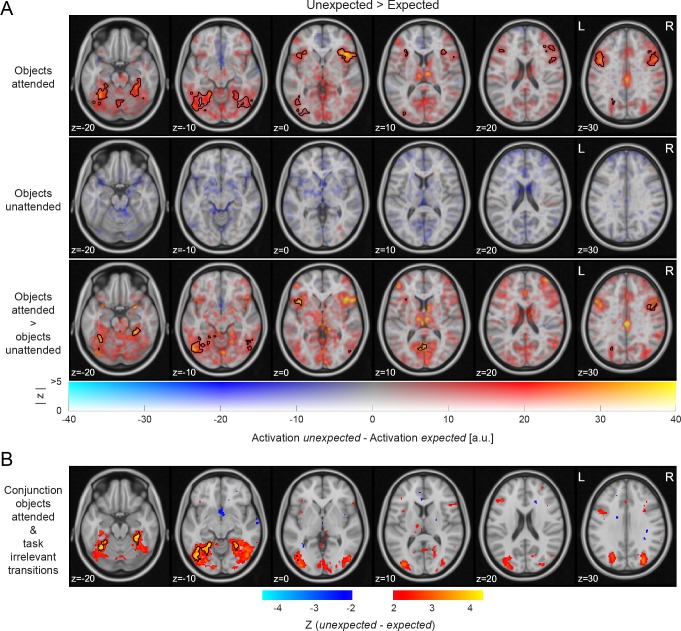
Expectation suppression across cortex for attended object stimuli only.(A) Widespread expectation suppression across cortex in the objects attended condition. Displayed are parameter estimates for unexpected minus expected image pairs overlaid onto the MNI152 2 mm template. Color indicates unthresholded parameter estimates: red-yellow clusters represent expectation suppression. Opacity represents the z statistics of the contrasts. Black contours outline statistically significant clusters (GRF cluster corrected). Significant clusters included major parts of the ventral visual stream (early visual cortex, LOC, TOFC), anterior insula, and inferior frontal gyrus during the objects attended condition (upper row). No significant clusters were evident in the objects unattended condition (middle row). The interaction (attended >unattended; bottom row) showed significant clusters similar to those of the attended condition, albeit less extensive. (B) Expectation suppression across the ventral visual stream for attended objects, but with task-irrelevant predictions. Displayed are z statistics of the contrast unexpected minus expected of the conjunction: attended task-relevant predictions ∪ task-irrelevant predictions; data of task-irrelevant predictions from Richter et al. (2018). Exclusively the ventral visual stream clusters showed significant expectation suppression in this conjunction, while all non-sensory area clusters were no longer significant. Thus, only the ventral visual stream clusters displayed a sensitivity to conditional probabilities, irrespective of whether predictions were task-relevant or task-irrelevant, as long as the predictable stimuli were attended.10.7554/eLife.47869.005Figure 2—source data 1.Expectation suppression across cortex for attended object stimuli only.The source data file contains nifti images for the whole brain contrast unexpected >expected (expectation suppression). Separate files are included for each attention condition, as well as their interaction (attended >unattended), both in terms of unthresholded parameter estimate, z and thresholded z-maps (Figure 2A). The thresholded z map of the conjunction analysis (Figure 2B) is also included.